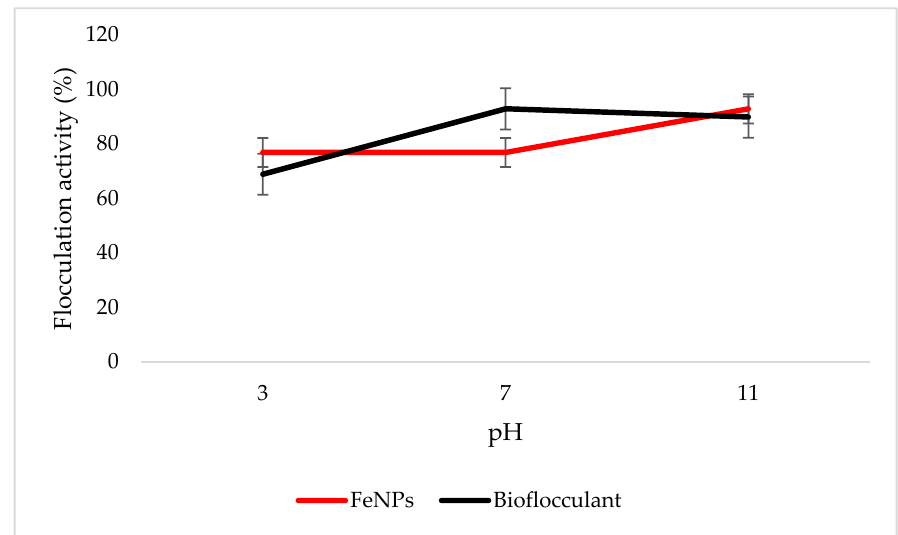
Figure 6. pH effect on flocculation activity. Error bars denote statistical significance at (p < 0.05).